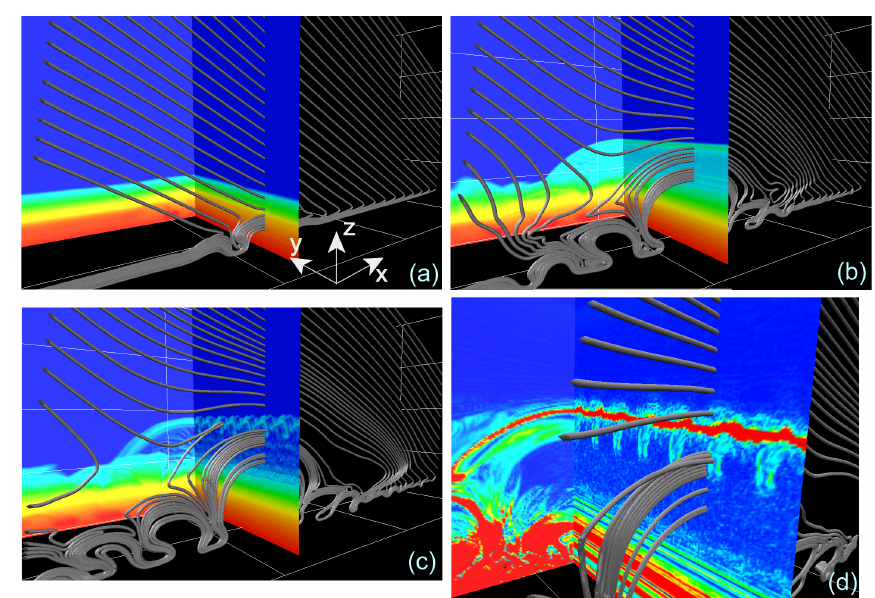
Figure 25: Magnetic Rayleigh–Taylor instability. The color shows mass density distribution in panels (a)–(c) and current density distribution in panel (d). Image reproduced with permission from Isobe et al.